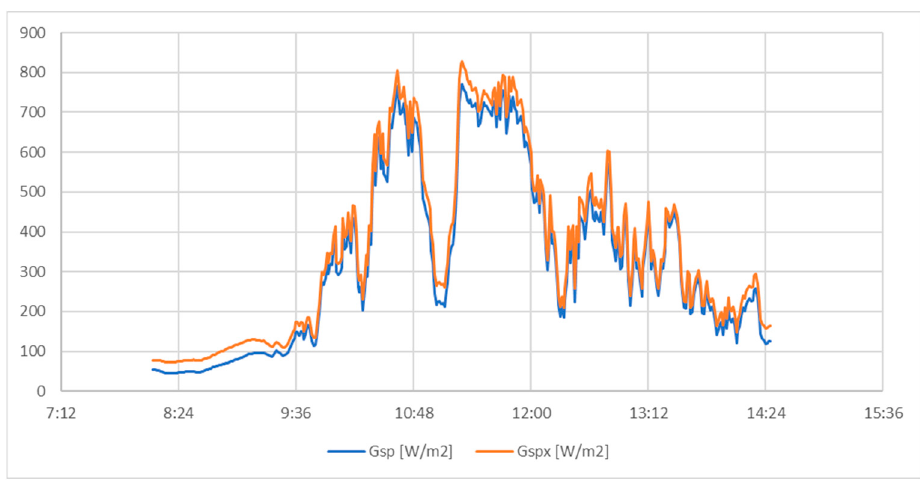
Figure 4. G SP and G SPX waveform for moderate clouds